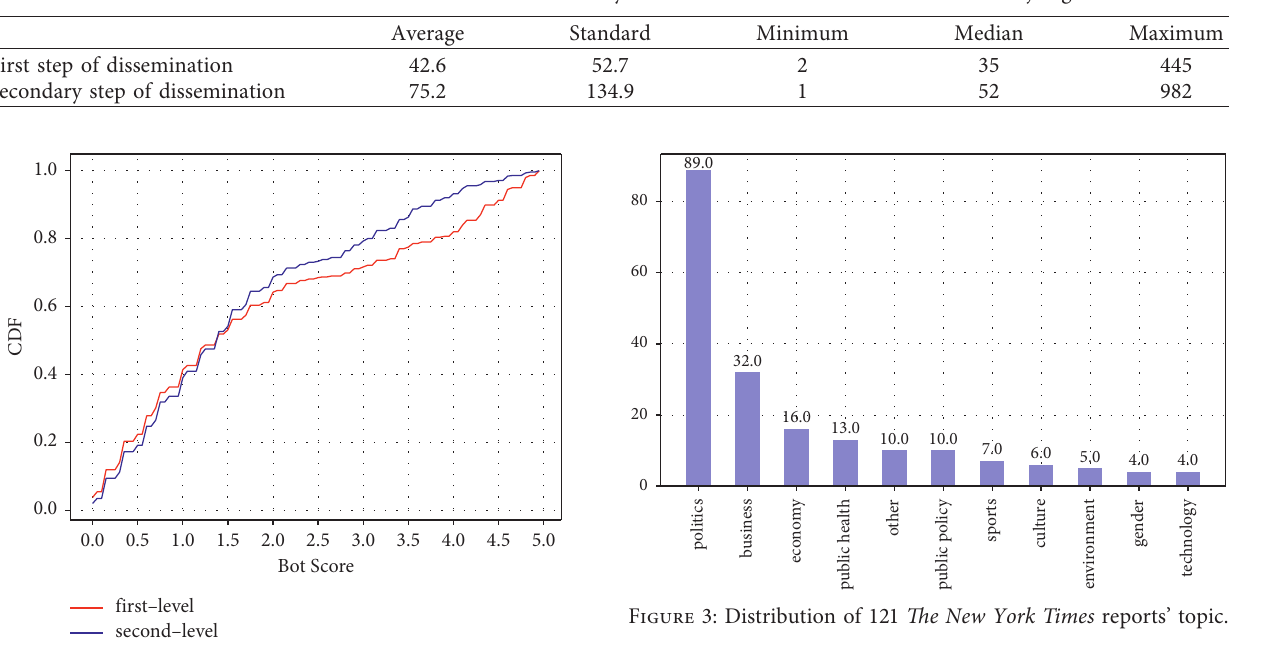
Figure 1: Cumulative distribution of bot score contribution from 0 to 1 user for first- and secondary-level of communication.